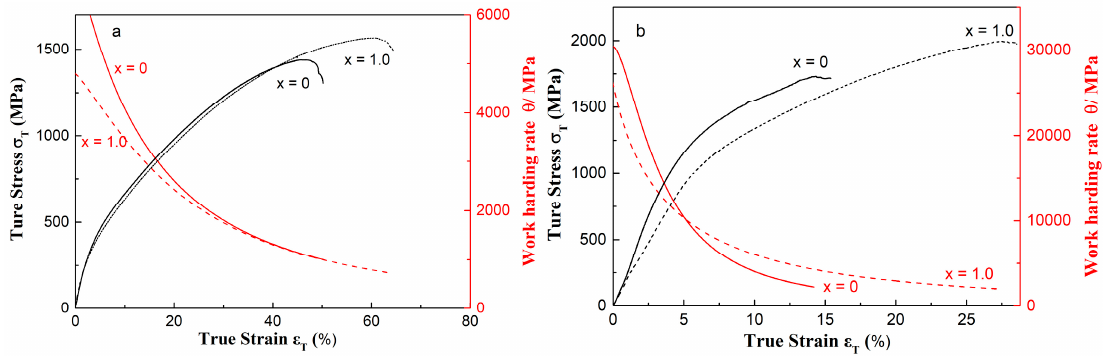
Figure 5. Work-hardening rate and true stress versus true strain curves of: ( a ) Fe 65.4 − x Ce x Mn 14.3 Si 9.4 Cr 10 C 0.9 and ( b ) Ti 40 − x Ce x Ni 40 Cu 20 (x = 0, 1.0) alloys.